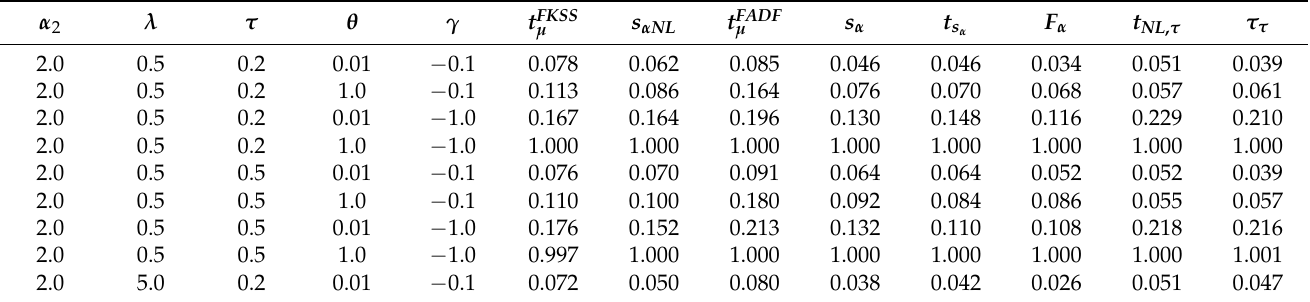
Table 6. The power comparison of alternative tests: Omay and Yıldırım data-generating processes (OY-DGP). α